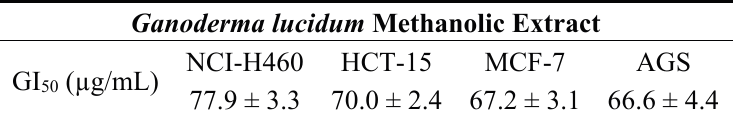
Table 1. GI 50 concentrations of the cold methanolic extract of G. lucidum fruiting body in various human tumor cell lines a .